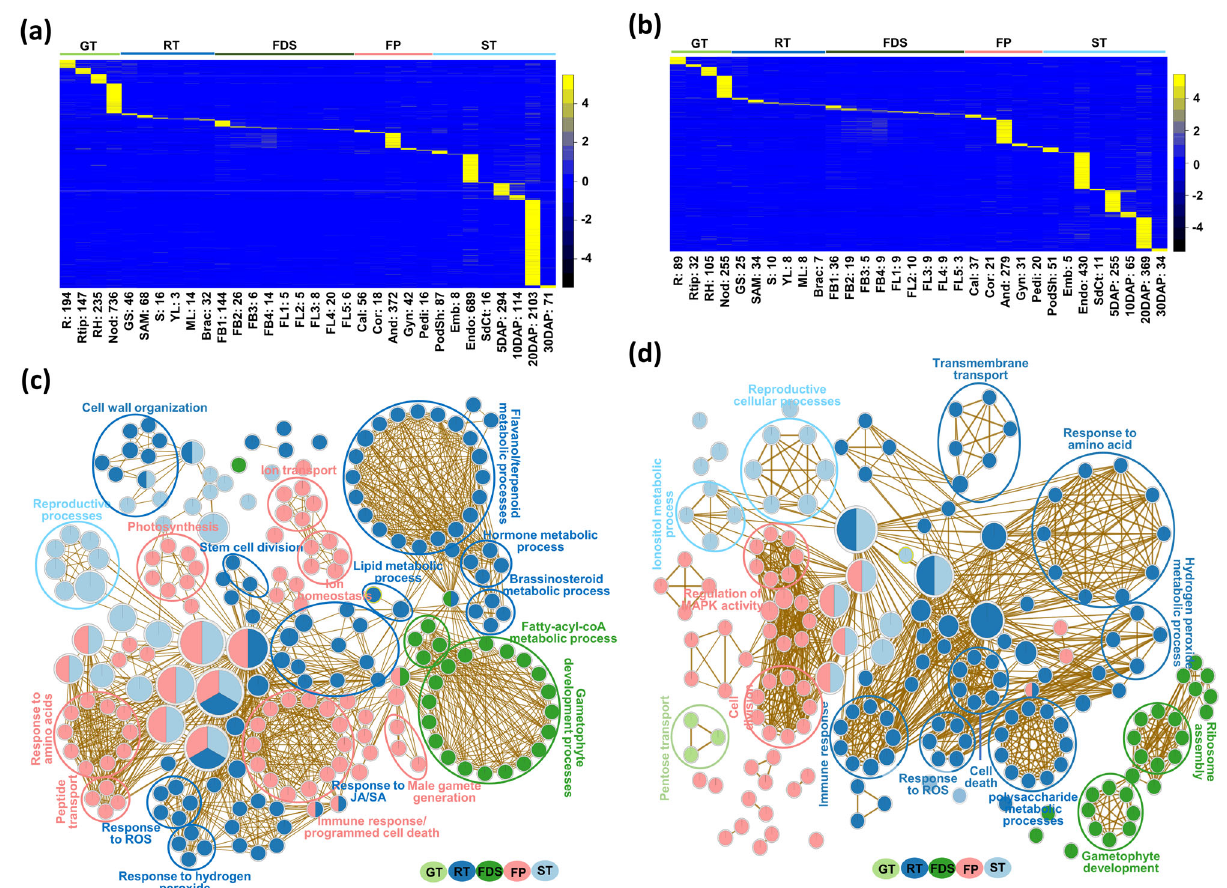
Fig. 3 Tissue-speci fi city and comparative gene ontology (GO) enrichment map analysis. a , b Heatmaps showing expression pro fi les of the tissue-speci fi c protein-coding genes (PCGs) ( a ) and lncRNAs ( b ) in different tissue samples. Numbers given at the bottom indicate the number of tissue-speci fi c genes/ lncRNAs identi fi ed in each tissue sample. Color scales showing the Z -score are given on the right side. c , d Comparative GO enrichment maps of the tissue- speci fi c PCGs ( c ) and lncRNAs ( d ) in the fi ve groups. GO terms associated with different groups, green tissues (GT), root tissues (RT), fl ower development stages (FDS), fl ower parts (FP), and seed tissues (ST), are indicated in different colors. Only the signi fi cantly enriched ( P value ≤ 0.05) biological process GO terms are